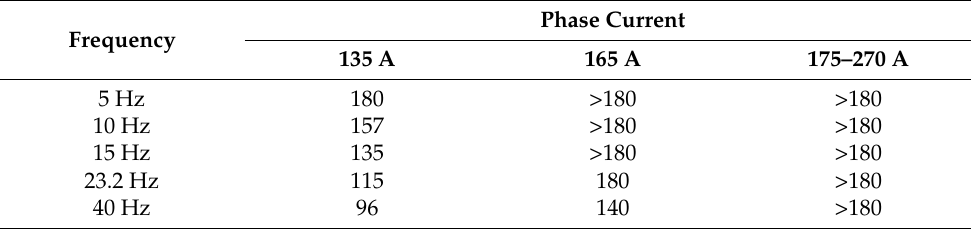
Table 6. Maximum steady-state primary winding temperatures during natural cooling.